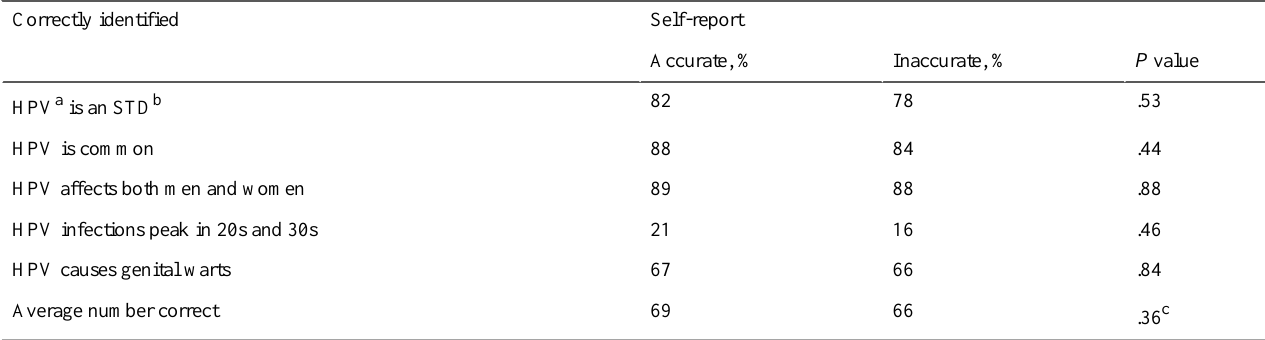
Table 5. Association between baseline knowledge of HPV and accuracy of self-reporting.